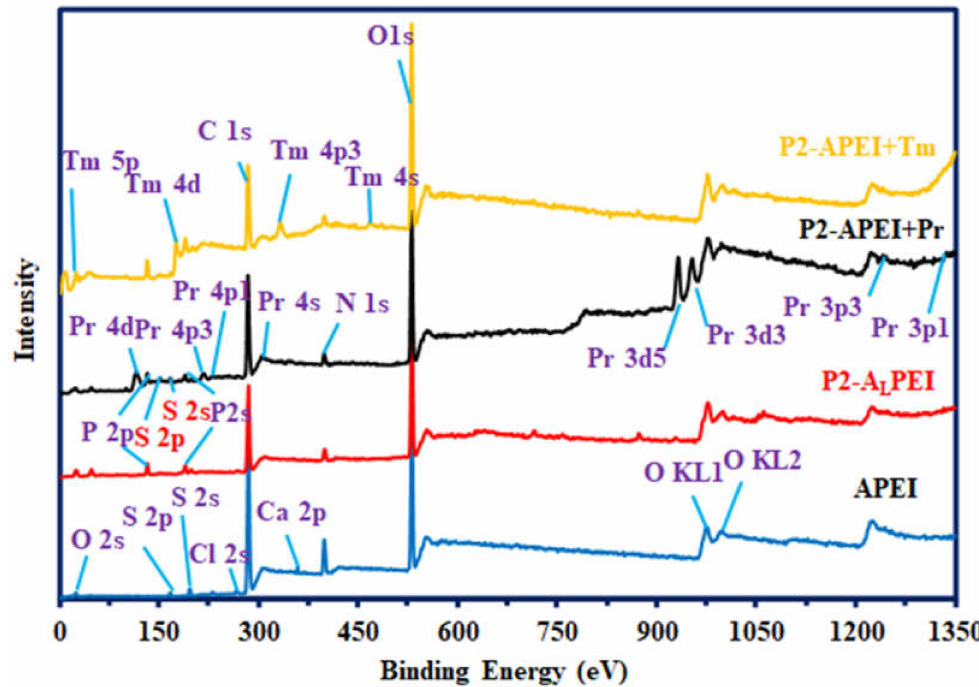
Figure 3. XPS survey scans of APEI and P2-APEI beads (including after Pr(III) and Tm(III)